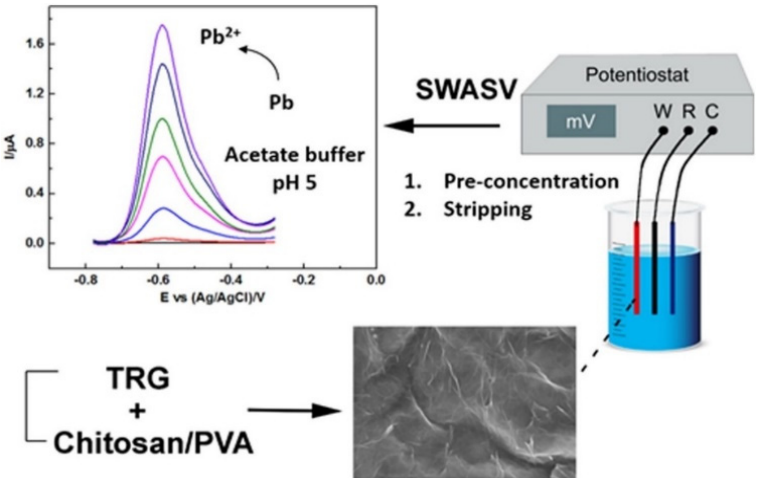
Figure 7. Modification of thermally reduced graphene/chitosan/polyvinyl alcohol nanocomposite as an electrode for Pb(II) detection in wastewater [132].